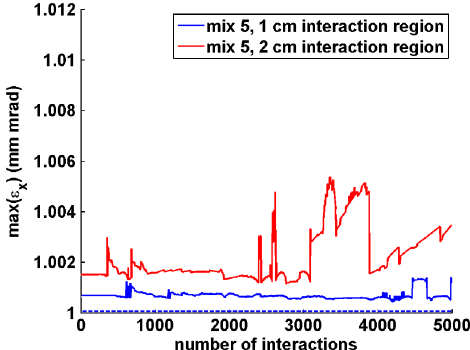
FIG. 15. Maximal emittance of a bunch after interaction with ion clouds of different width: 1 cm and 2 cm of mixture 5. The dotted line indicates the